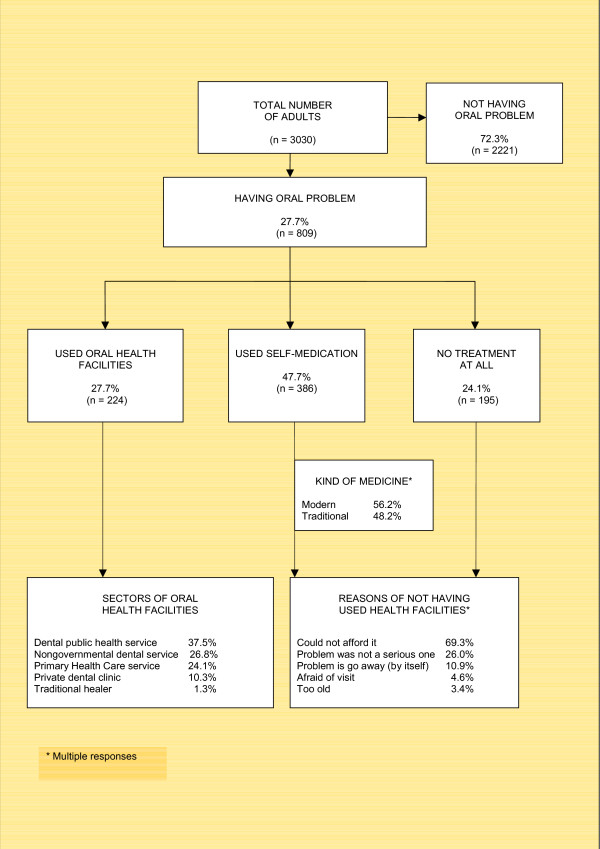
Responses to oral symptoms.